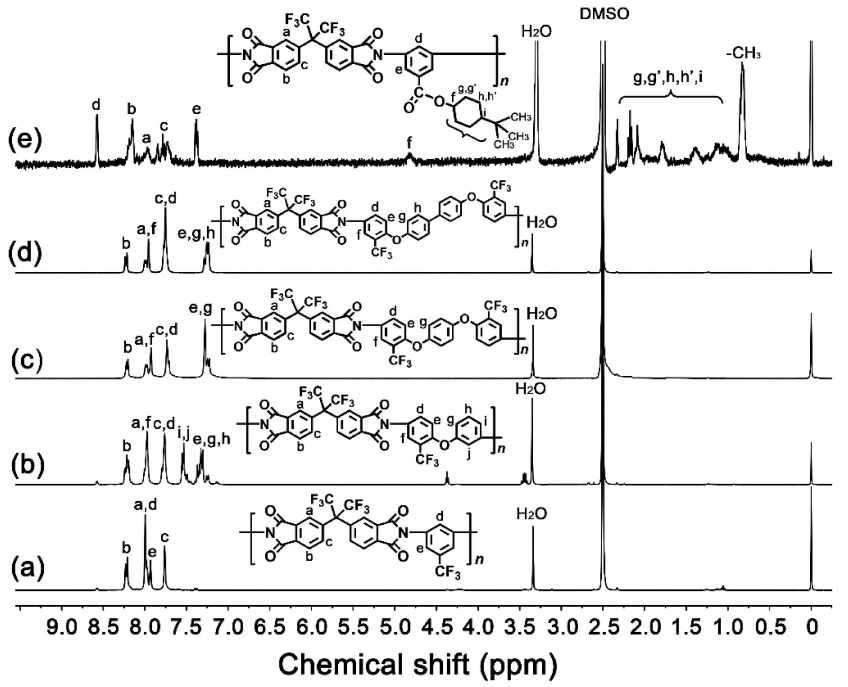
Figure 3. 1 H-NMR spectra of FPI resins. ( a ) FPI-1, ( b ) FPI-2, ( c ) FPI-3, ( d ) FPI-4, ( e )